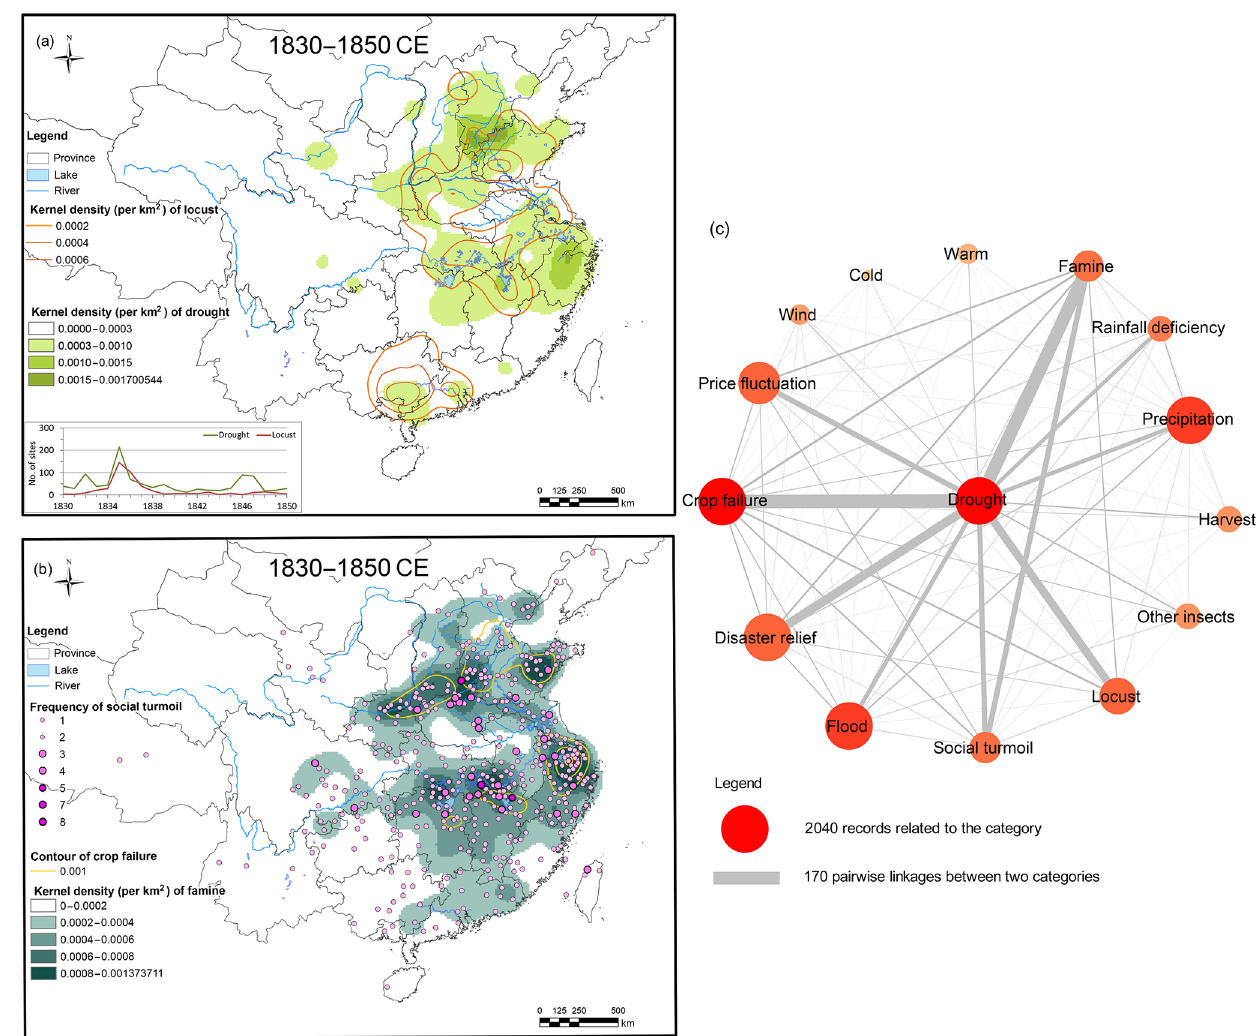
Figure 10. Spatial distribution of the kernel density function of drought and locust outbreaks (a) and social turmoil (b) , and the social network chart (c) in the drought period